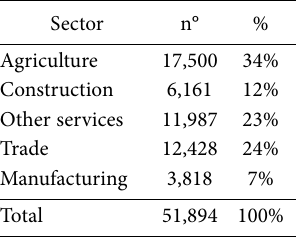
Table 2. Number and % of Basilicata’s manufacturing firms